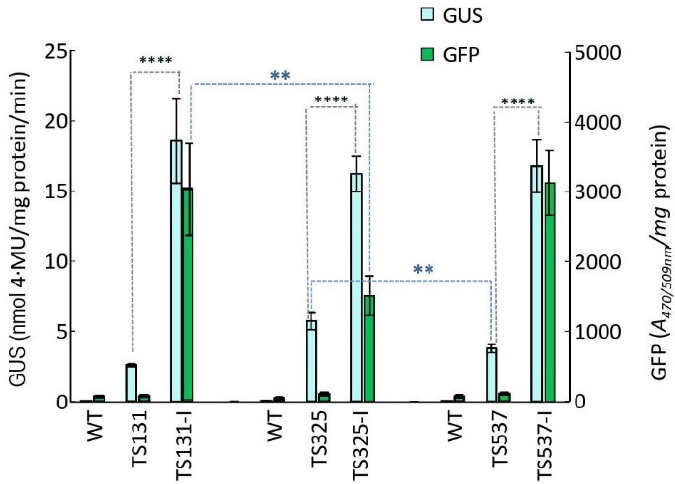
Figure 3. Expression of reporter genes in T2 integrant rice seedlings. T2 homozygous seedlings (TS131-I, TS325-I, TS537-I) were grown in nutrient solution for 21 days before assaying for GUS and GFP activity. Controls were WT (as in Figure 1) and T1 homozygous target line seedlings (TS131, TS325, TS537). Values are mean ± SD n = 6 to 9, (**) p < 0.01; (****) p < 0.0001, Fisher’s Least Significant Difference (LSD).